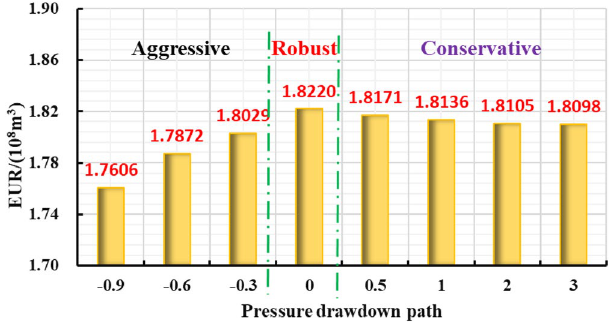
Figure 35. Diagram of relationship between EUR and pressure drop